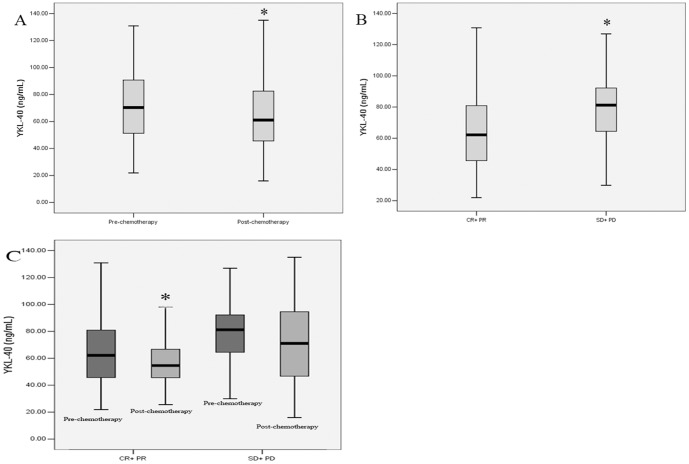
Distribution of serum YKL-40 levels.Serum YL-40 levels in the SCLC patients significantly decreased after chemotherapy (p = 0.026) (A). The pre-chemotherapy serum YKL-40 levels were lower in the sensitive to chemotherapy group than in the resistant to chemotherapy group (p = 0.004) (B). Serum YKL-40 of responders after chemotherapy were significantly decreased (p = 0.029), while YKL-40 of non-responders did not change significantly (p = 0.256) (C).